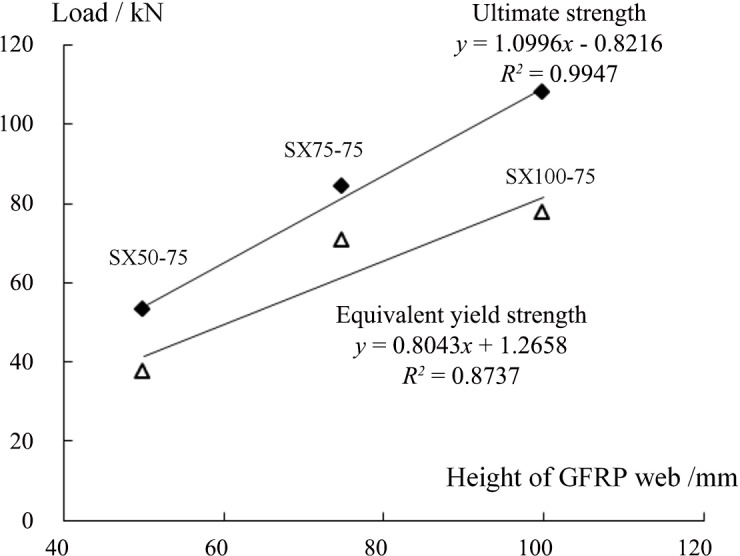
Relationship between the specimen load and web height.